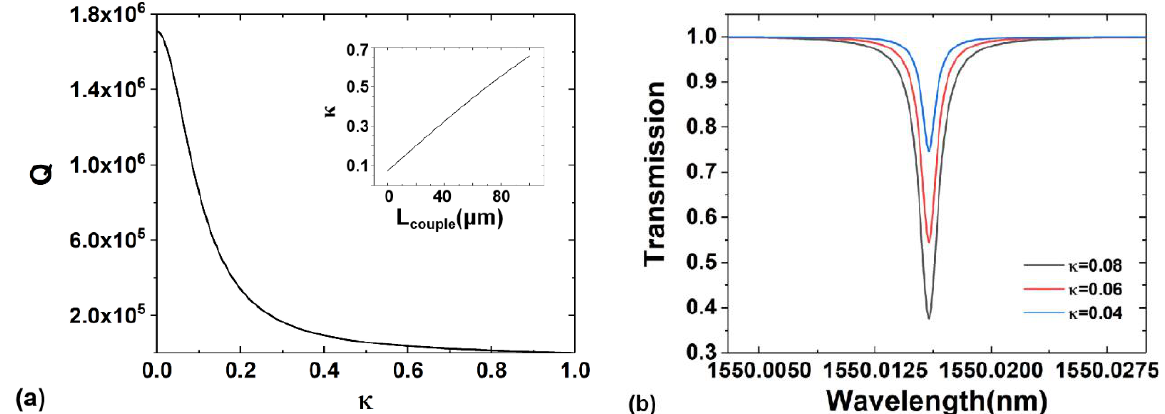
Figure 7. ( a ) Function relationship between quality factor (Q) and coupling coefficient κ . Inset: function of coupling coefficient κ and coupling length L couple when gap = 0.8 µ m. ( b ) Transmission line with coupling coefficient κ of 0.04, 0.06 and 0.08 around 1550 nm.